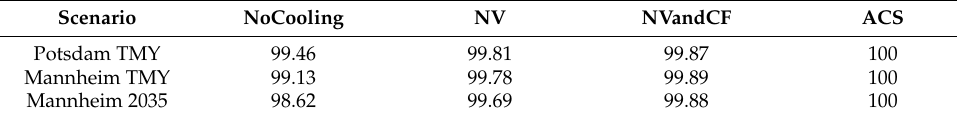
Table 15. Relative performance values [%] for the three representative